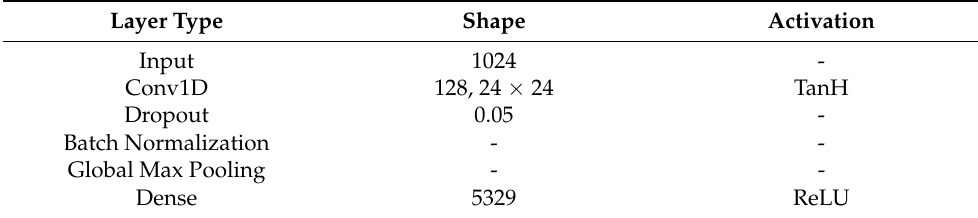
Table 3. The architecture of the convolutional model.